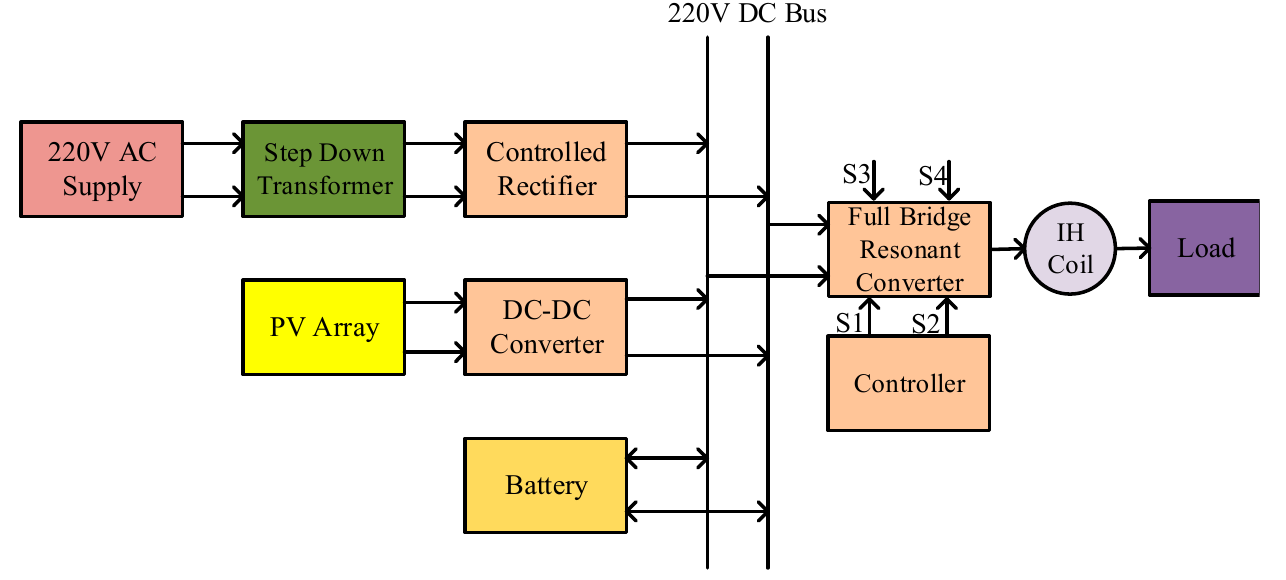
Figure 3. Block diagram of the proposed induction heating system.